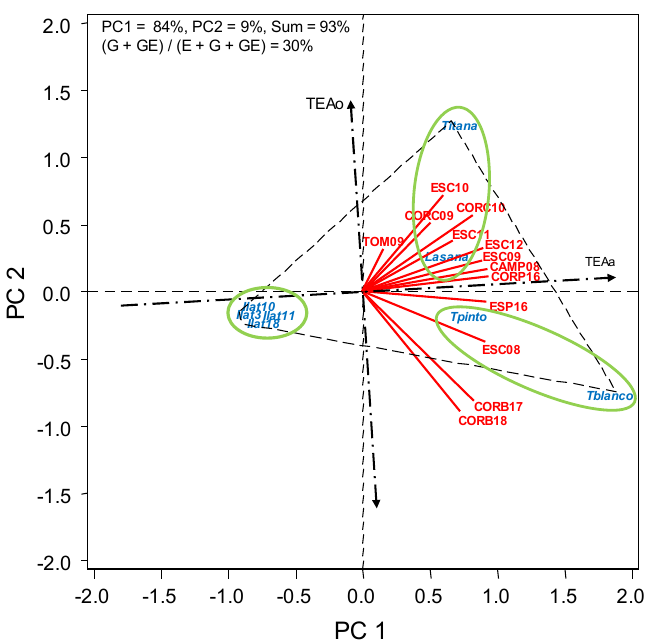
Figure 2. HA-GGE biplot based on the number of broomrapes per plant of 8 selected grass pea accessions in 13 environments (combination location–year). The genotypes are in italics and the environments are abbreviated as in Table 1. Environments ALM17, ALM18, ESP17, ESP18 were free of broomrape infection and therefore are not included in this biplot.